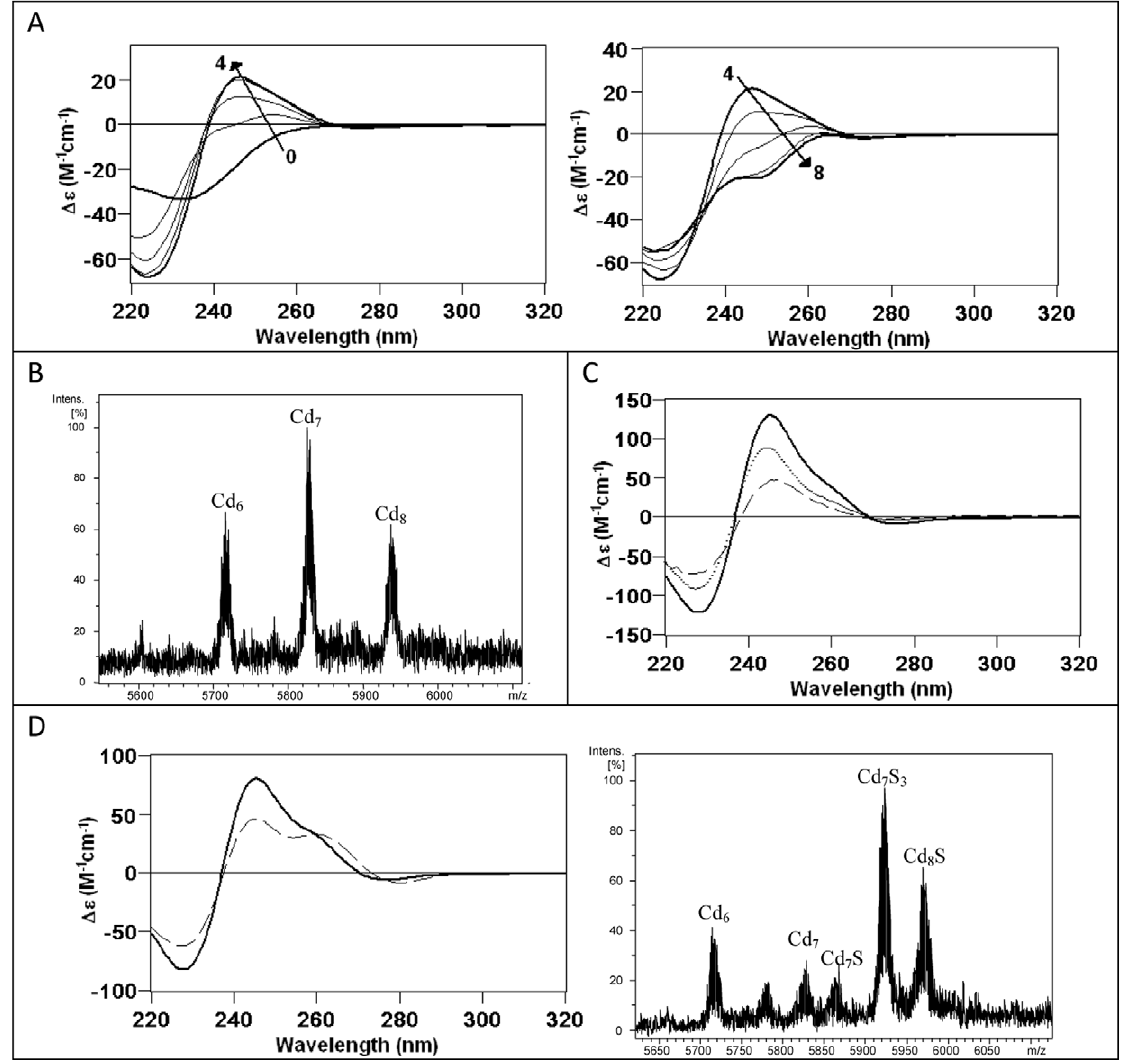
Figure 9. The invitro Cd(II) binding abilities of BfMT2 points to a partial preference for divalent metal ion coordination. (A) CD corresponding to the titration of a 10 m M solution of Zn-BfMT2 with Cd(II) at pH 7.0 from 0 to 4 and from 4 to 8 Cd(II) eq added. (B) Deconvoluted ESI- MS spectrum of an aliquot corresponding to the addition of 8 Cd(II) eq to Zn-BfMT2. (C) Comparison of the CD spectra of the recombinant Cd-BfMT2 preparation (solid line), the acidified and reneutralized sample (dashed line), and the latter after the addition of 4 sulfide equivalents (dotted line). (D) Comparison of the CD spectra of the Cd-BfMT2 sample before (solid line) and after (dashed line) 28-days of evolution under inert atmosphere and ESI- MS spectrum of the final